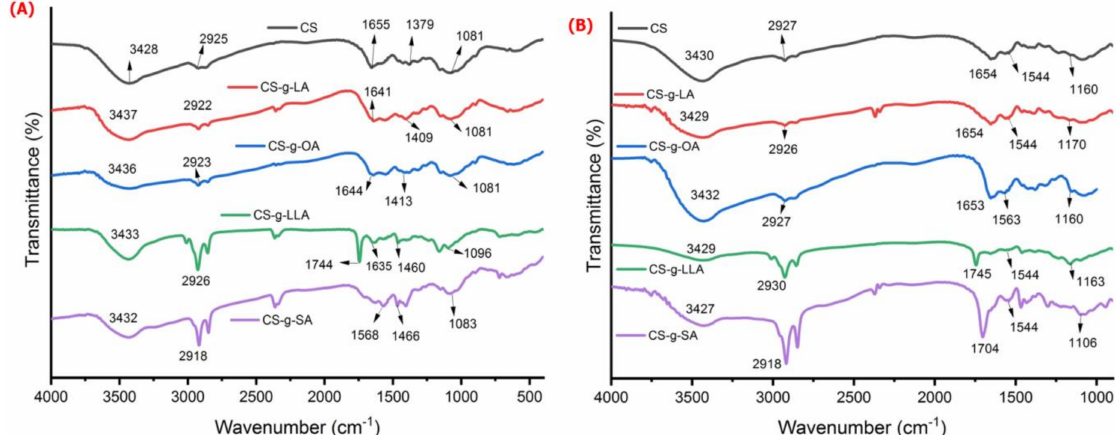
Figure 1. Comparison of the FTIR spectrums of pure CS with that of four CS amides ( A ) and the crosslinked ones ( B ).